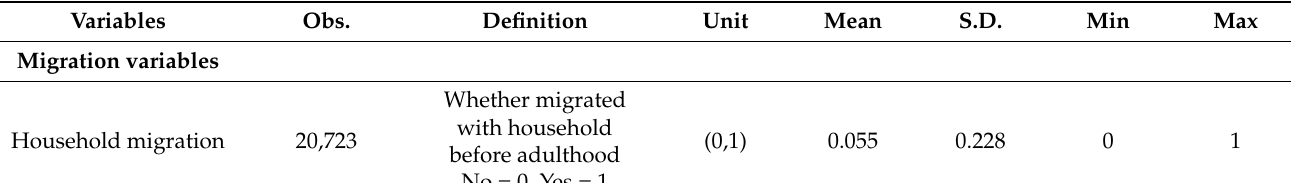
Table 1. Descriptive statistical